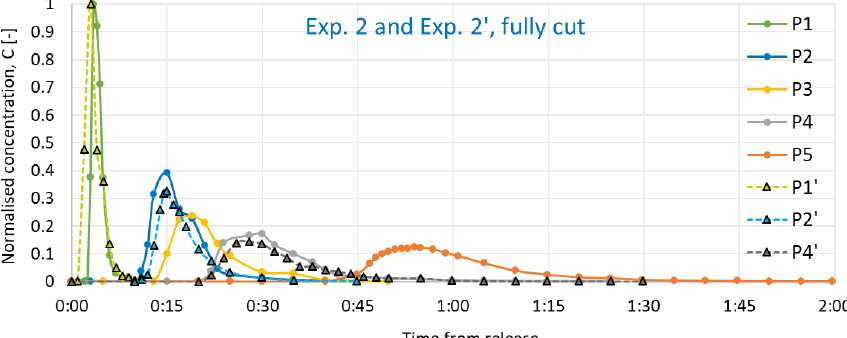
Figure A1. Tracer concentrations in measured cross-sections normalised with the maximum concentration in the first cross-section P1. Fully cut conditions, original Exp. 2 (cross-sections P1, P2, P3, P4 and P5) and repeated experiment Exp. 2’ (cross-sections P1’, P2’ and P4’).